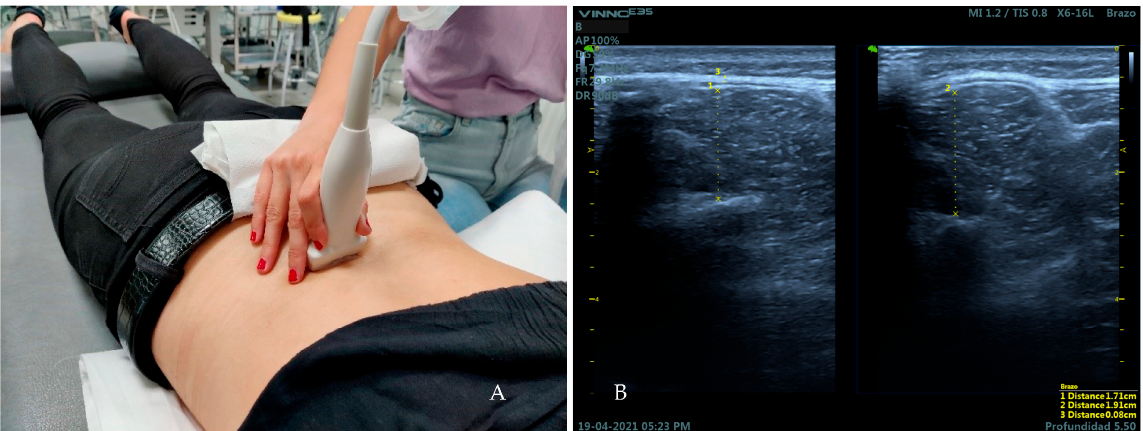
Figure 3. Placement of the transducer over the L4 vertebral level for the measurement of the variables of the lumbar multifidus muscles and TLF ( A ). Ultrasound image obtained over this area ( B ). Distance 1 corresponds to the thickness of the lumbar multifidus muscle at rest Distance 2 corresponds to the thickness of the lumbar multifidus muscle at contraction. Distance 3 corresponds to the thickness of the TLF.